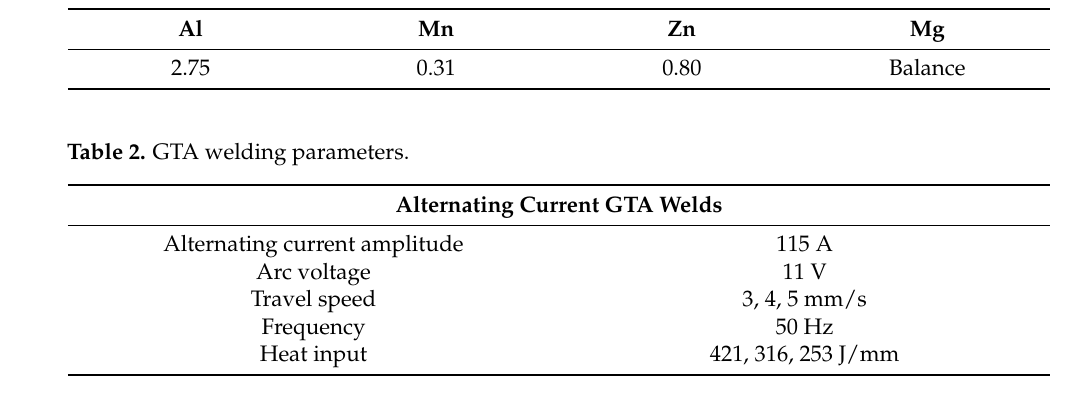
Table 1. Chemical composition of AZ31 Mg alloy (wt.%).